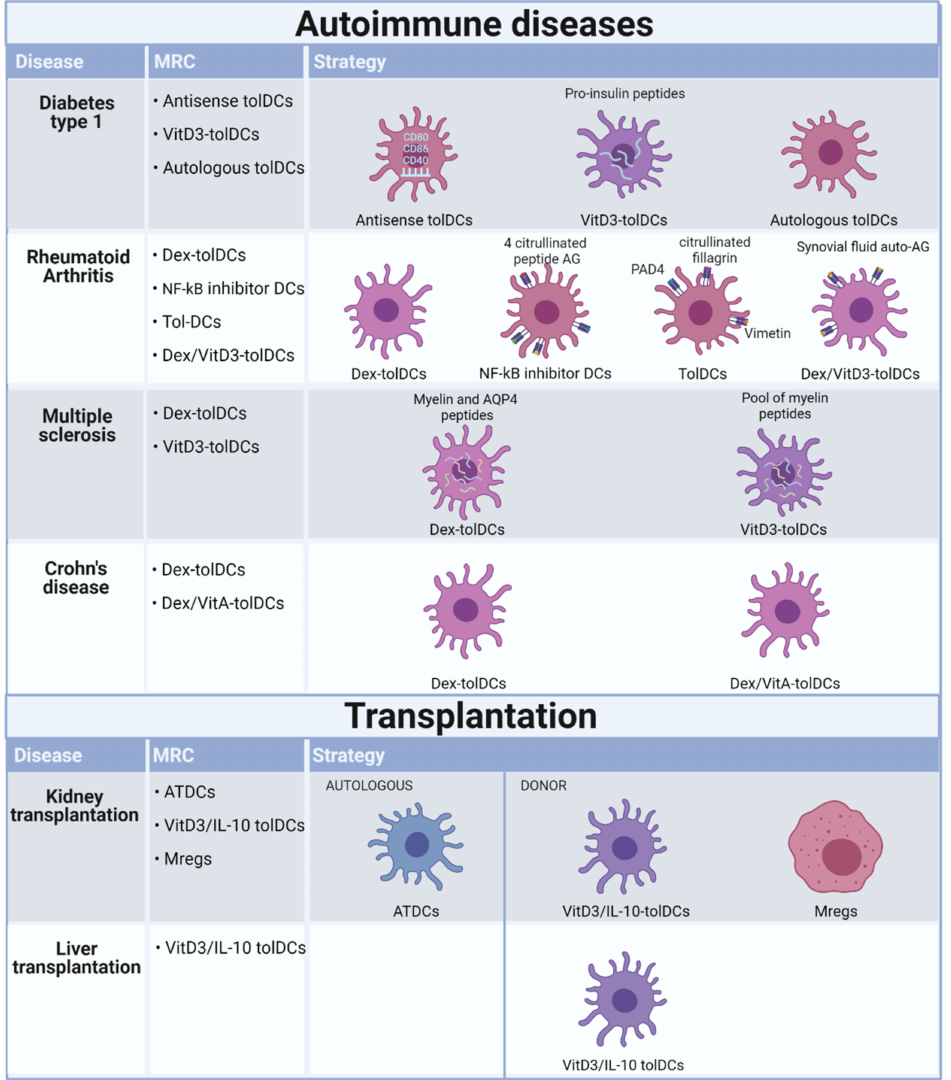
Figure 2. Tolerogenic dendritic cells (tolDCs) and regulatory macrophages (Mregs) studied in phase I/II clinical trials for several autoimmune diseases and kidney-/liver transplantation. Studies conducted for type I diabetes have used three different strategies, where the route of injection and frequency of injection differs per study. DIABETES MELLITUS TYPE I: monocyte-derived tolDCs were injected four times intradermally in a bi-weekly scheme [26]. The vitamin D3 (VitD3)-tolDCs loaded with proinsulin were injected two times intradermally with a 28-day interval. The autologous dendritic cells were injected intravenously in three monthly injections. RHEUMATOID ARTHRITIS: Dexamethasone (Dex)tolDCs were injected intra-arterially in a single infusion and dose escalation [27]. Nuclear factor kappa-light chain enhancer of activated B (NF-kB) inhibitor tolDCs, one dose of 2 progressive levels was injected intradermally [28].The route of injection of tolDCs pulsed with four different antigens are unknown but was injected five times in a two-dose regimen. Dex-VitD3-tolDCs loaded with synovial fluid were injected intralesionally in a dose-escalation via a single injection [29]. MULTIPLE SCLEROSIS: The Dex-tolDCs loaded with myelin peptides and aquaporin-4-derived peptides (AQP4) were injected in three injections, administered bi-weekly [30]. Two different clinical studies used the same subset of Dex-tolDCs loaded with a pool of myelin peptides but were injected either intranodally or intradermally. Both were dose escalation trials of six injections, four bi-weekly and two monthly injections [31]. CROHNS DISEASE: Dex-tolDCs were injected intralesionally (frequency unknown). Dex/Vitamin A (VitA)-tolDCs were injected intraperitoneally in a dose escalation of single injection versus three injections biweekly [33]. KIDNEY TRANSPLANTATION: Autologous tolDC (ATDC) was injected intravenously in a single injection one day before the transplantation. VitD3/interleukin (IL)-10 tolDCs were injected intravenously, single infusion one week before transplant. Mregs were injected intravenously 6/7 days before transplantation [32]. LIVER TRANSPLANTATION: VitD3/IL-10 tolDCs were injected intravenously in a single injection one week before immunosuppressive weaning. Created with